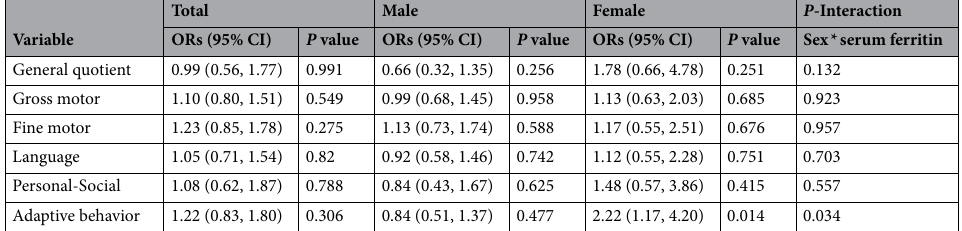
Table 4. Logistic regression analyses of neurodevelopmental delays and iron deficiency (serum ferritin < 12 ng/mL vs. serum ferritin ≥ 12 ng/mL). The ORs were adjusted for maternal education, parity, feeding at six months, infant age, height, and weight. P value for the interaction between sex and serum ferritin, with the following variables also included in the model: maternal education, parity, feeding at six months, infant age, height, and weight. ORs Odds ratios, CI Confidence